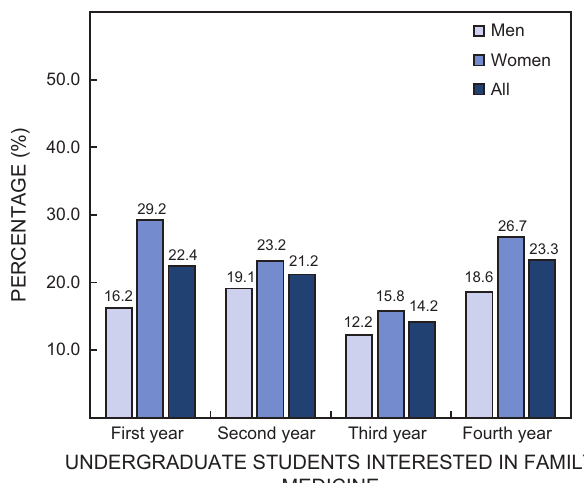
10.020.030.040.050.0